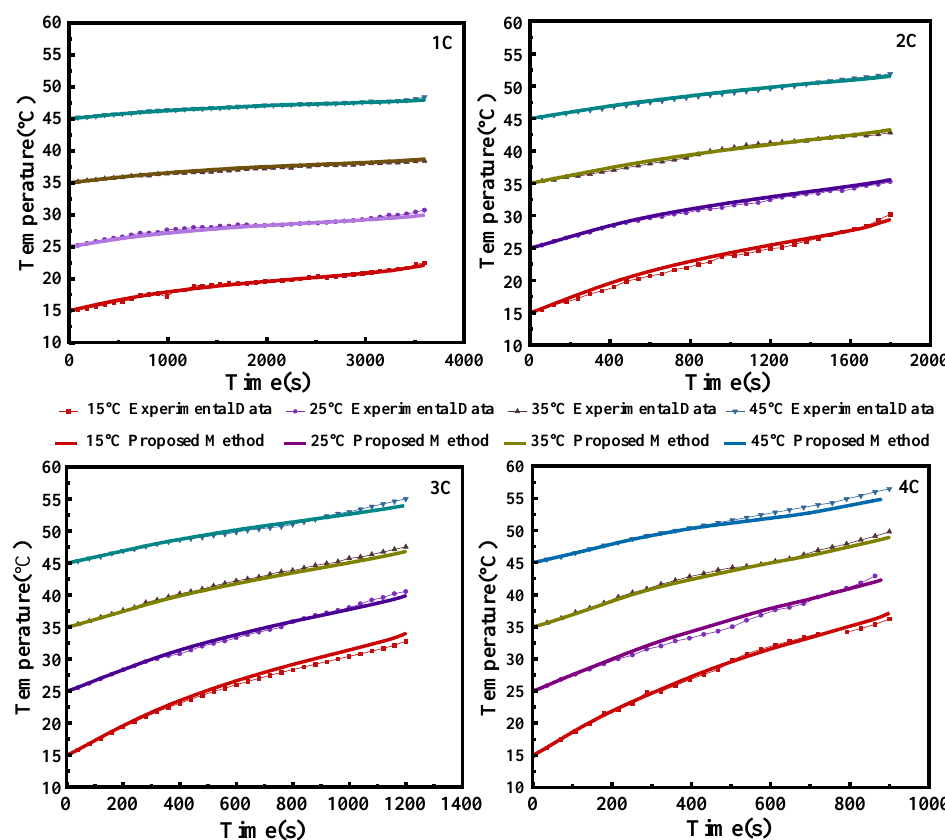
Figure 9. Battery experimental versus simulated temperature estimation. Table 2. Voltage MAE and RMES values of the